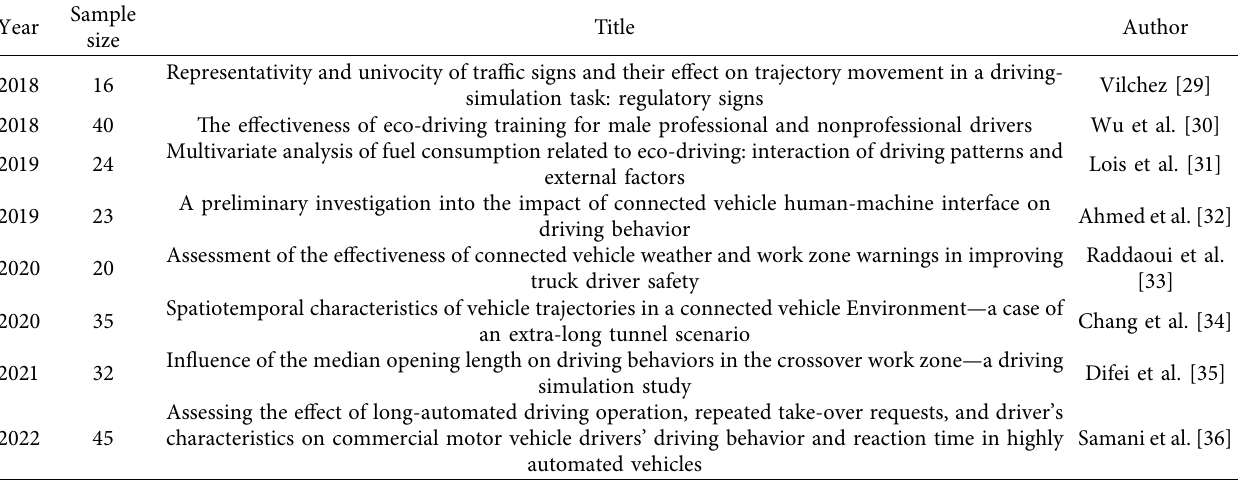
Table 2: Typical examples of the sample size in previous